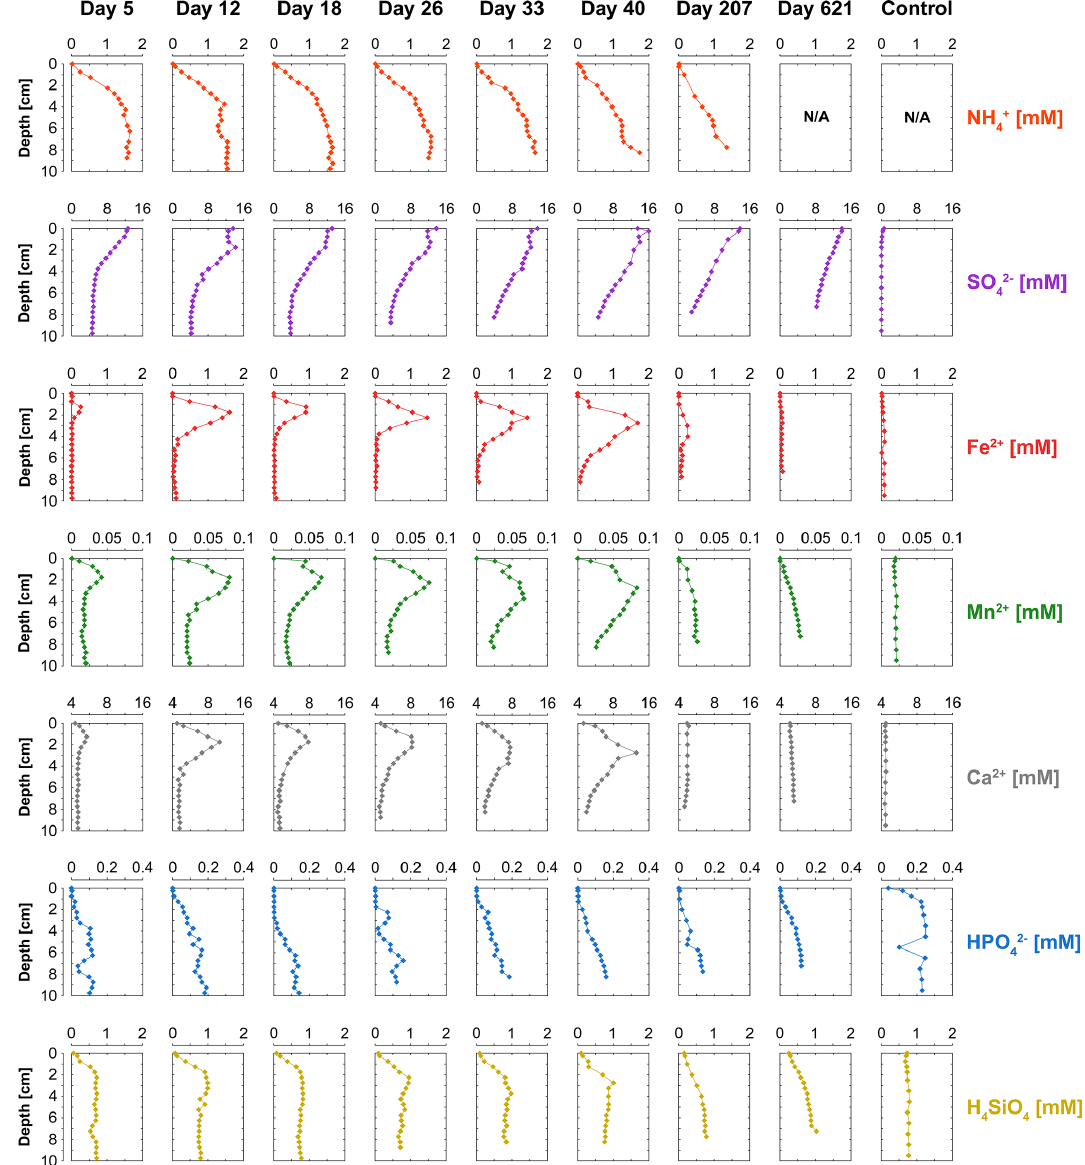
Figure 5. Time series of pore water depth profiles of NH + and H 4 SiO 4 (yellow). The control core was sampled at day